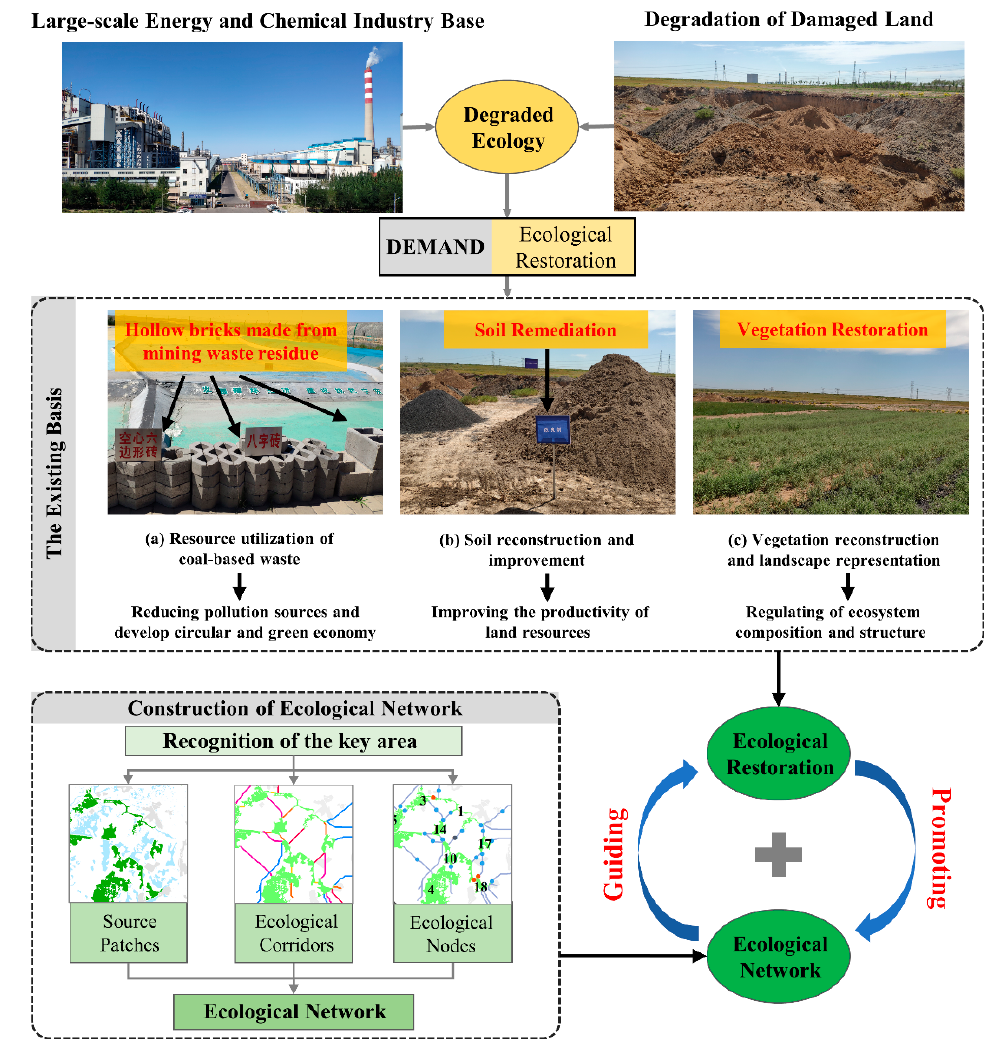
Figure 13. Combine the construction of ecological network with ecological restoration.